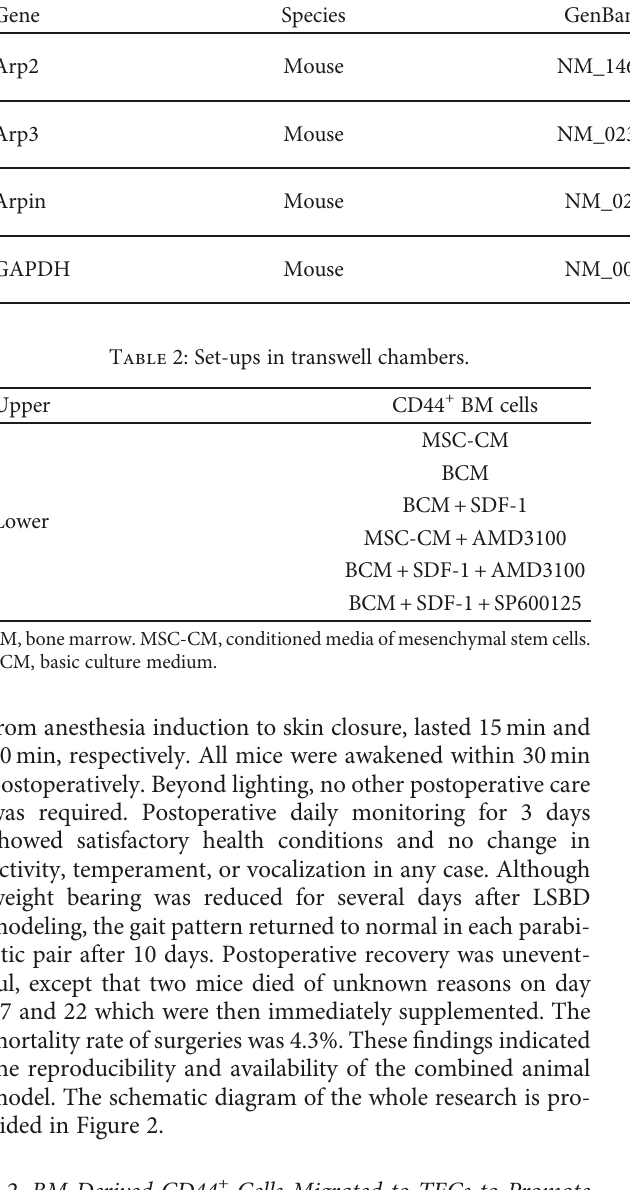
Table 1: Primers used for RT-PCR.